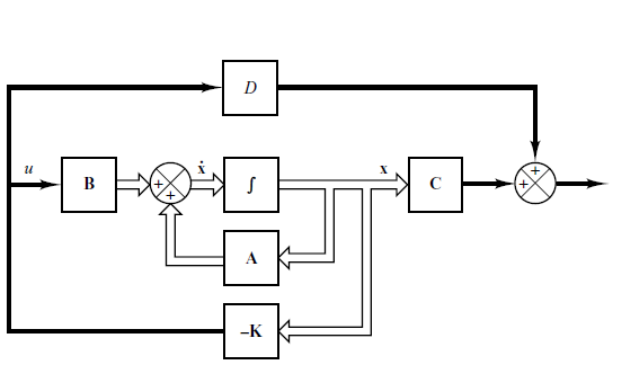
Figure 2. Full state feedback block